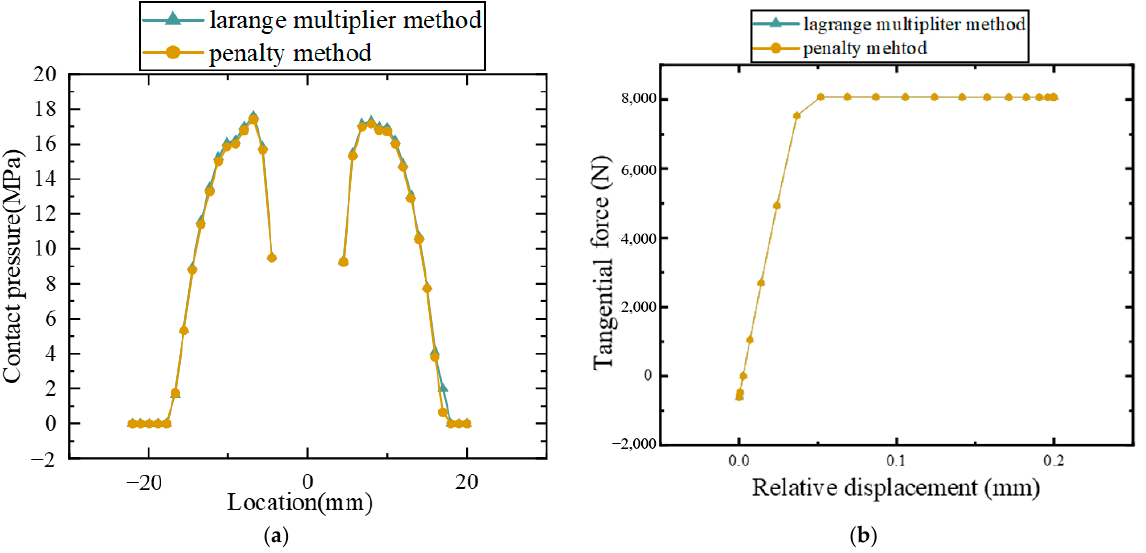
Figure 16. Calculation results of the Lagrange multiplier method and the penalty method: ( a ) contact pressure distribution curves, ( b ) backbone curves.